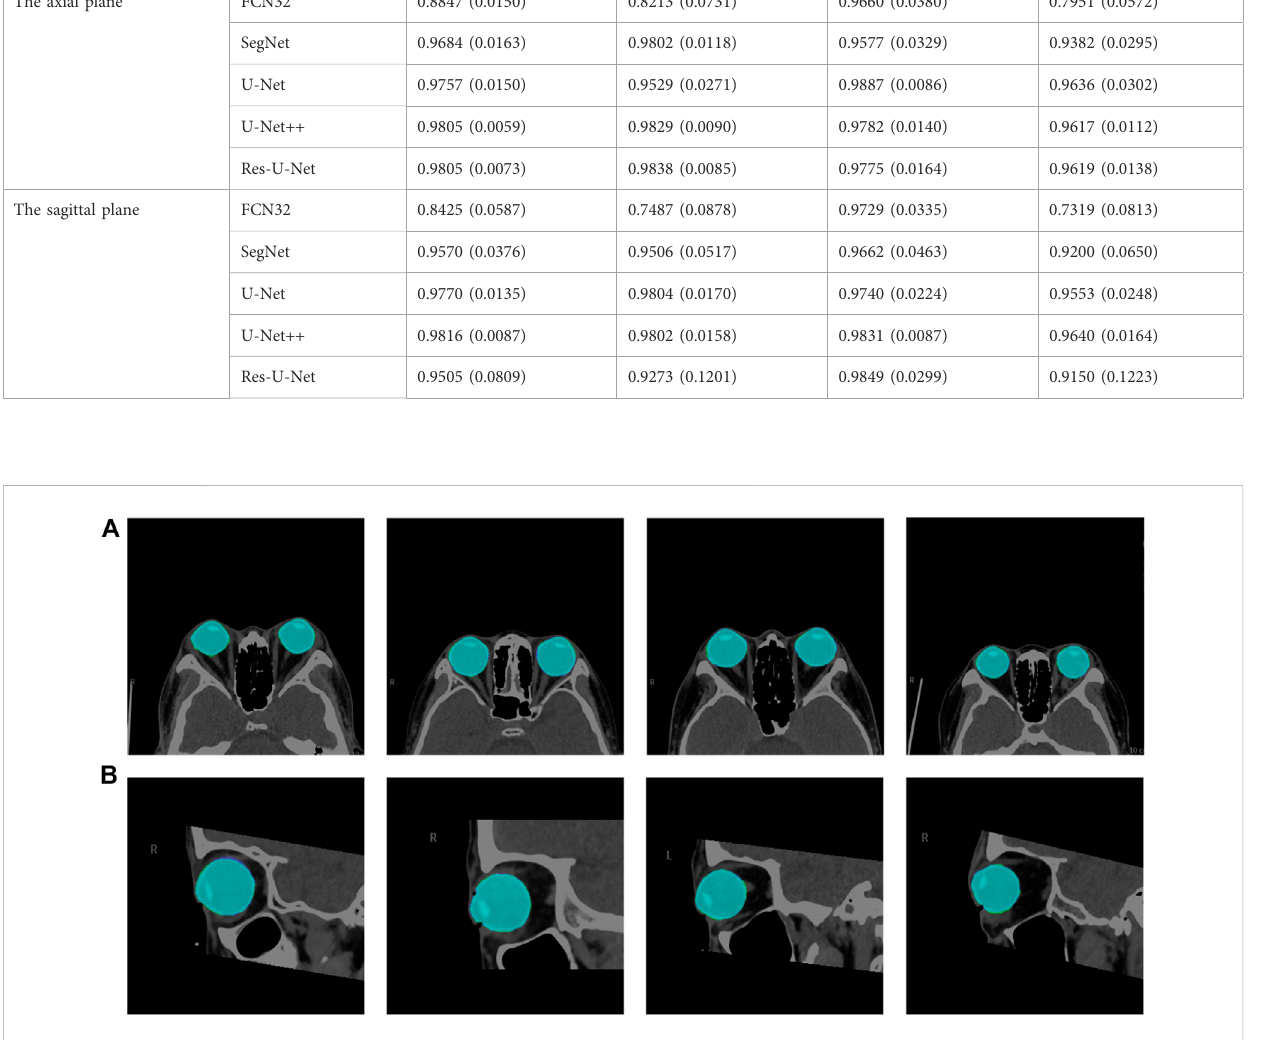
FIGURE 6 Visualization segmentationresults of the model used to segment the eye region. Row (A) represents the visual segmentationresults of the model in theaxialplaneofthetestset,androw (B) representsthevisualsegmentationresultsofthemodelinthesagittalplaneofthetestset.Thepurpleandgreen area represent the segmentation masks predicted by the manual and network, respectively. The light blue area is the overlapping part of both, i.e., the correctly predicted eye